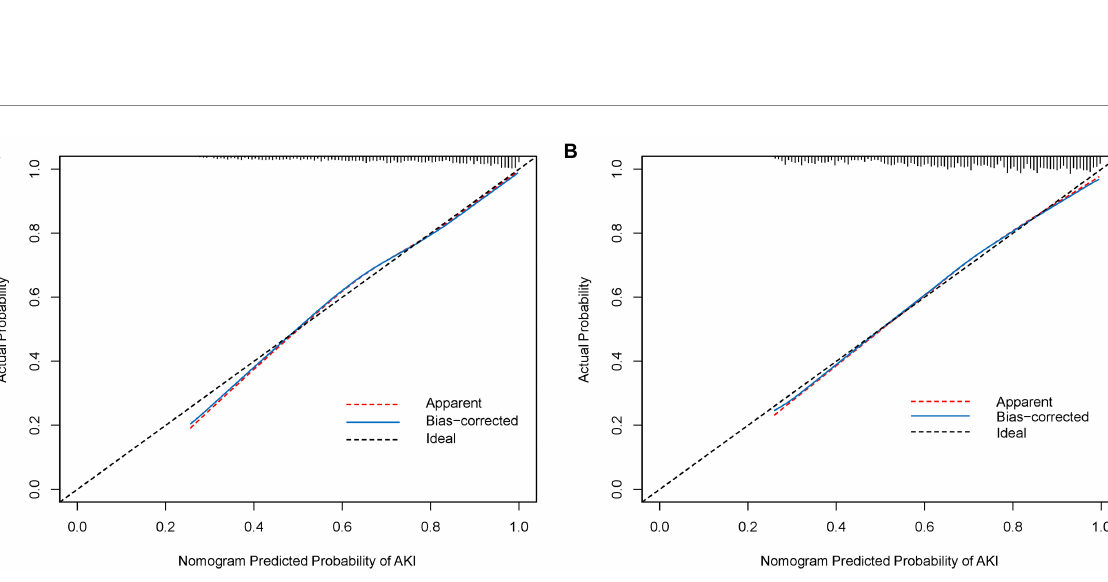
FIGURE 3 (A) Calibration curve of the nomogram in the derivation cohort. (B) Calibration curve of the nomogram in the validation cohort. The red dotted line represents the entire cohort, and the blue solid line is bias-corrected by bootstrapping ( B = 1,000 repetitions), indicating observed nomogram